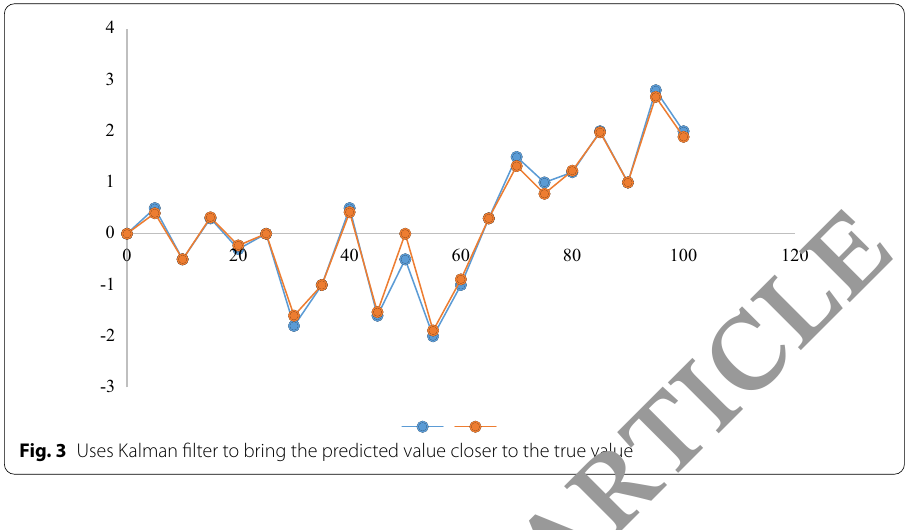
Fig. 3 Uses Kalman filter to bring the predicted value closer to the true